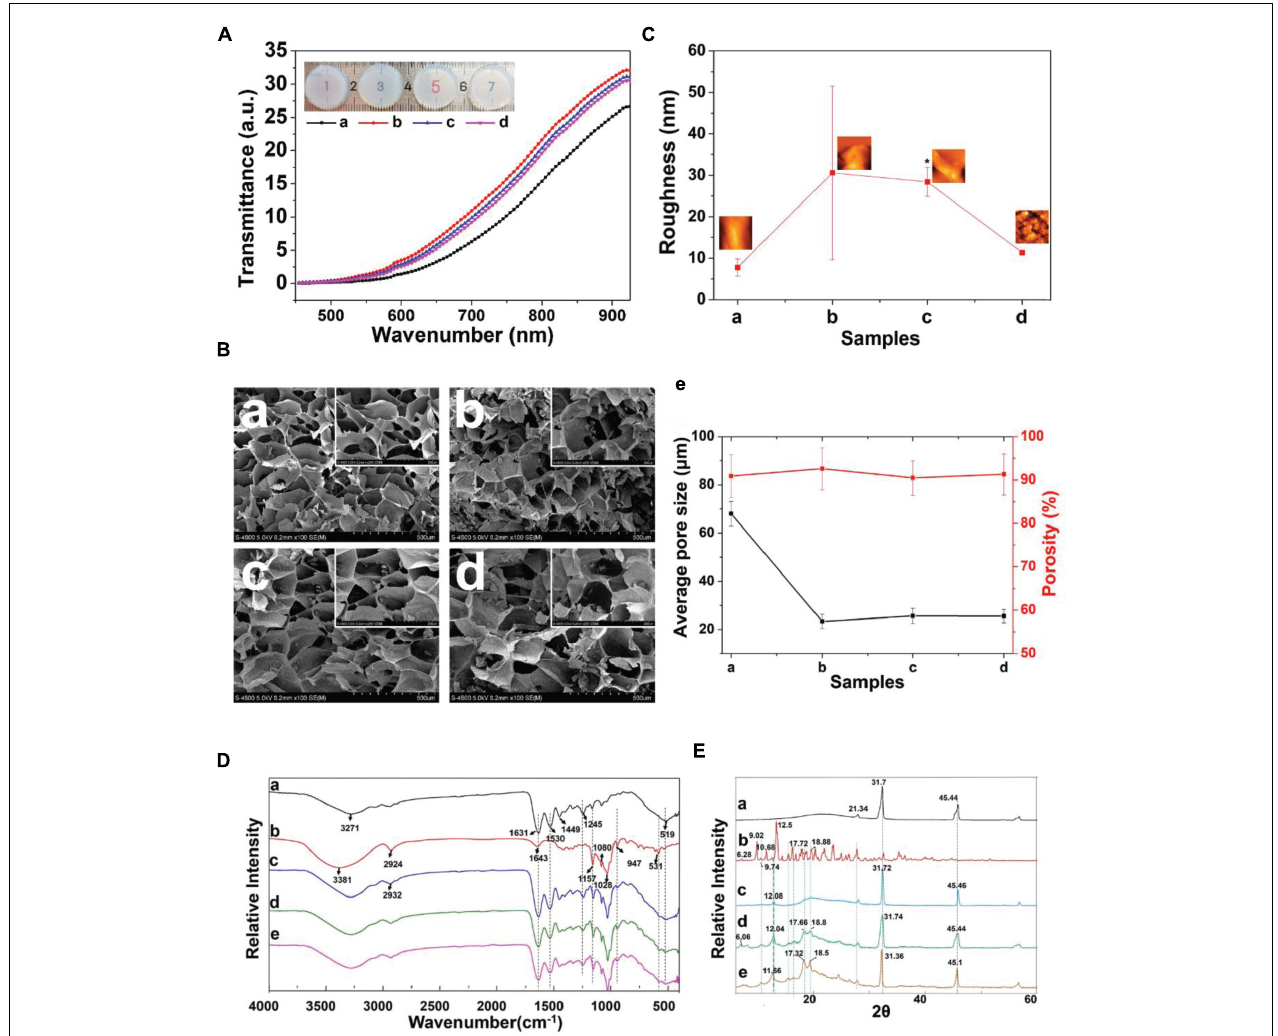
FIGURE 2 | Characterization of the GelMA + β -cd UV crosslinked hydrogel. (A) Transmittance of different β -cd gradient hydrogels. (Label description: (a) pure GelMA hydrogel, (b) with 2% β -cd, (c) with 3% β -cd, (d) with 4% β -cd. The following are the same except for FTIR and XRD). (Ba–d) Surface morphological images of lyophilized crosslinked hydrogels examined by low- and high-magnification SEM. β -cd was evenly dispersed in the hydrogels and blended excellently with GelMA. (e) The porosity and pore size of the freeze-dried hydrogels obtained by mercury intrusion porosimetry. (C) Representative AFM images and the root mean square roughness (Rq) of different hydrogels observed in height mode. (D) FTIR spectra of panels (a) pure GelMA, (b) pure β -cd, (c) GelMA with 2% β -cd, (d) GelMA with 3% β -cd, and (e) GelMA with 4% β -cd. (E) XRD pattern of panels (a) pure GelMA, (b) pure β -cd, (c) GelMA with 2% β -cd, (d) GelMA with 3% β -cd, and (e) GelMA with 4% β -cd. (* P < 0.05 was considered statistically